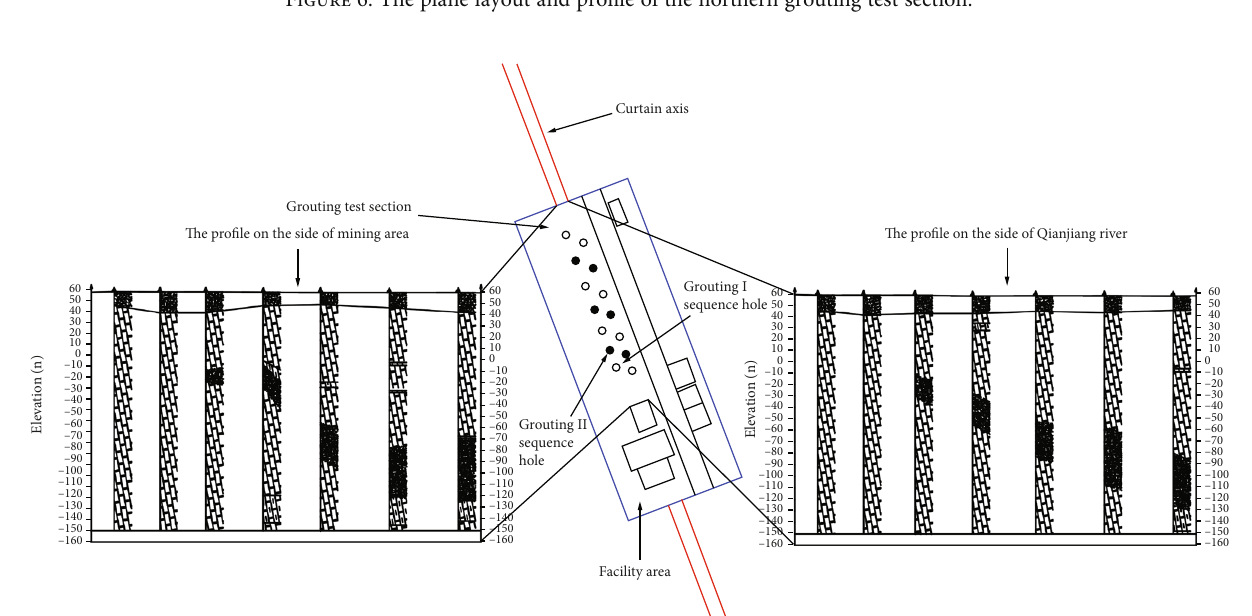
Figure 7: The plane layout and pro fi le of the southern grouting test